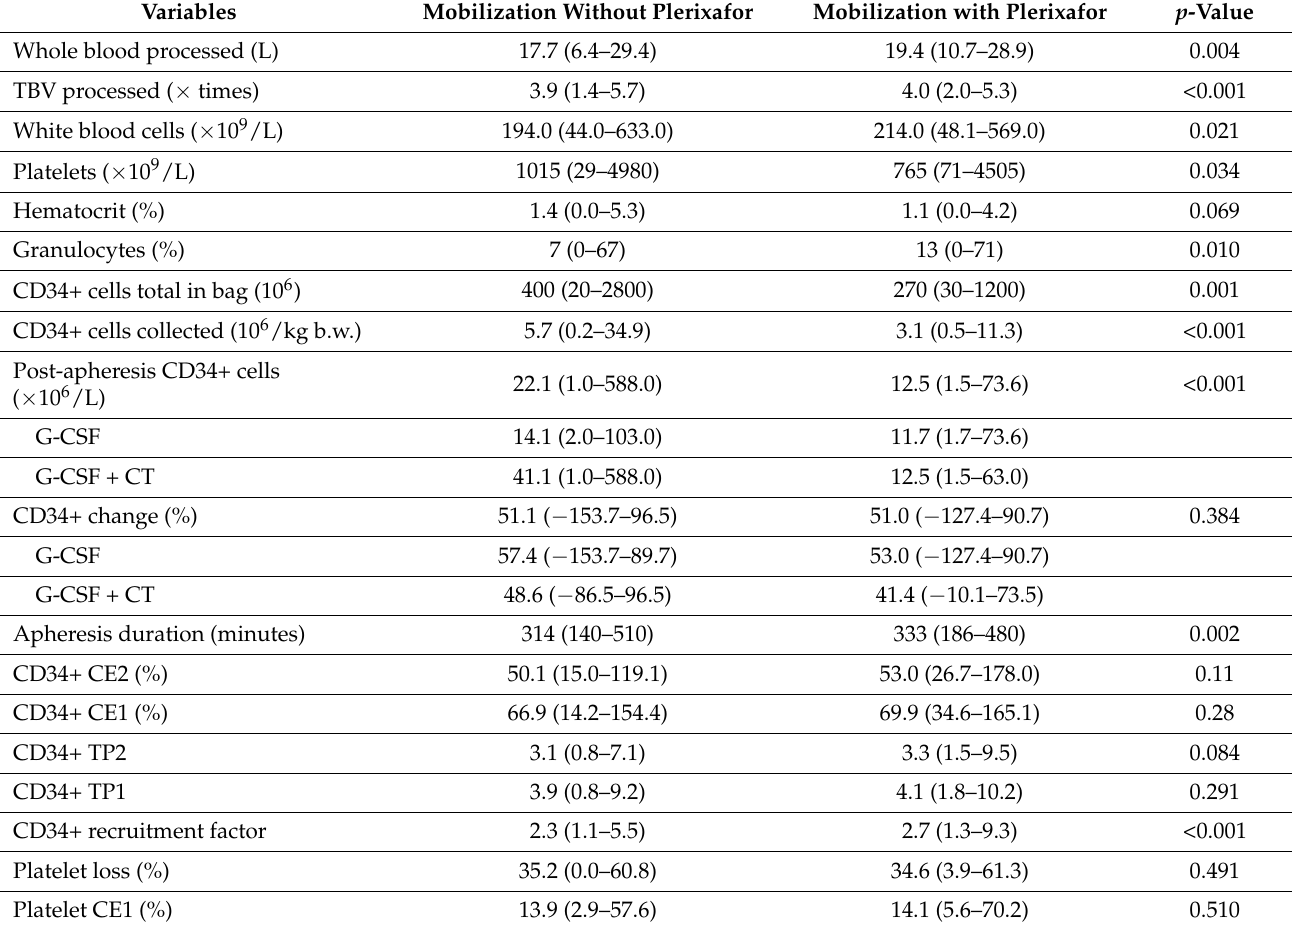
Table 2. Product characteristics and performance specifications for the Spectra Optia ® continuous mononuclear cell collection protocol for mobilization regimens without or with plerixafor.